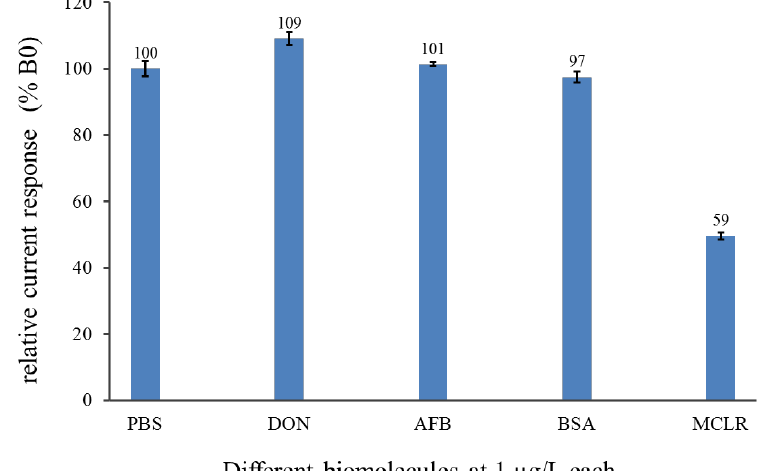
Figure 7. Comparison of 1 µg/L of each of DON, AFB 1 and BSA against 1 µg/L of MCLR and blank PBS.